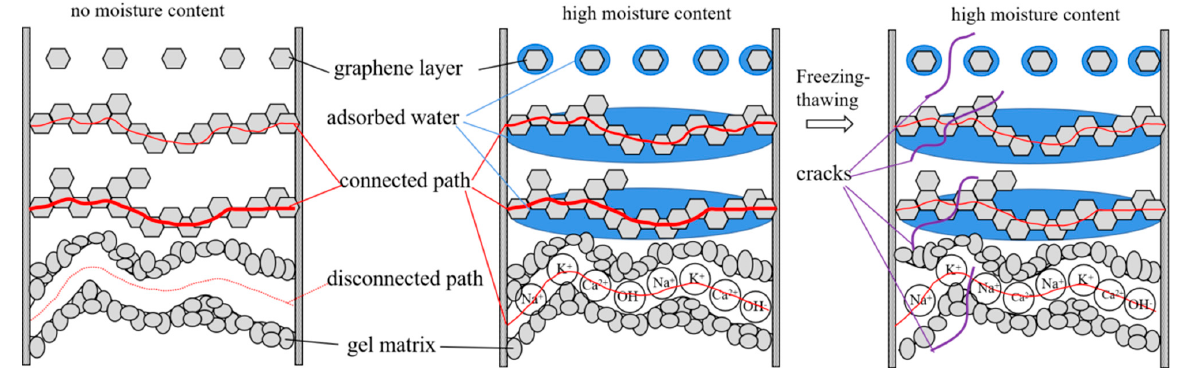
Figure 12. Microstructure schematic diagram of effect of humidity on electrical conductivity of graphene-based cement composites after freeze–thaw.